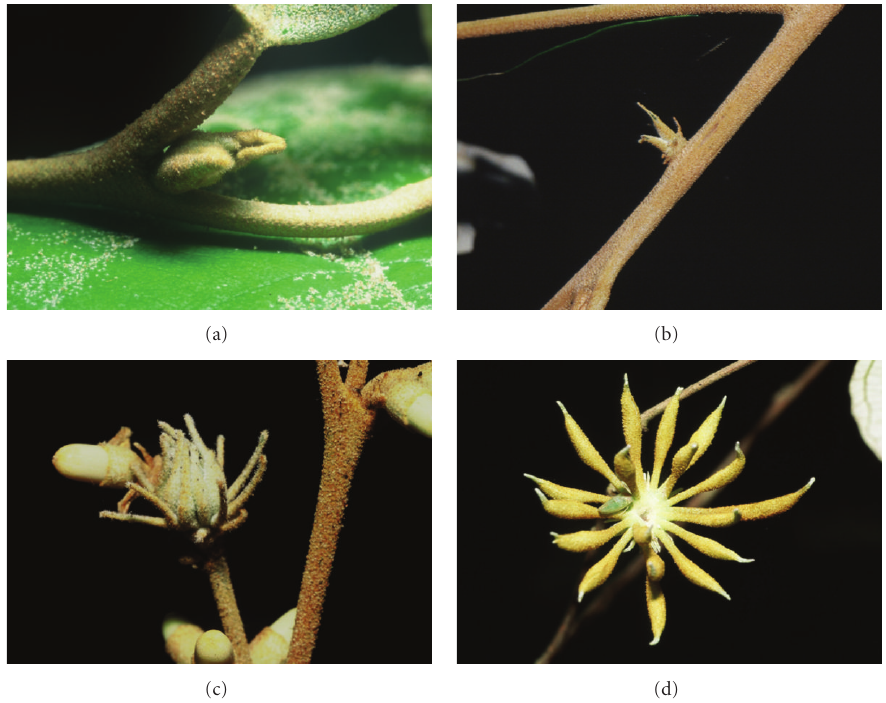
Figure 8: (a) An incipient gall of Pseudoregma koshunensis formed on an axillary bud of Styrax suberifolius (Taipei, Taiwan; 26 April 2005). (b) A very young gall of Ceratoglyphina styracicola formed on the stem of S. suberifolius (Sun Moon Lake, Taiwan; 18 July 1994). (c) A young gall of Pseudoregma bambucicola formed on an inflorescence of Styrax suberifolius (Fushan, Taiwan; 7 June 2004). (d) A young gall of Astegopteryx sp. on Styrax benzoides (Chiang Mai, Thailand; 1 August 2000).